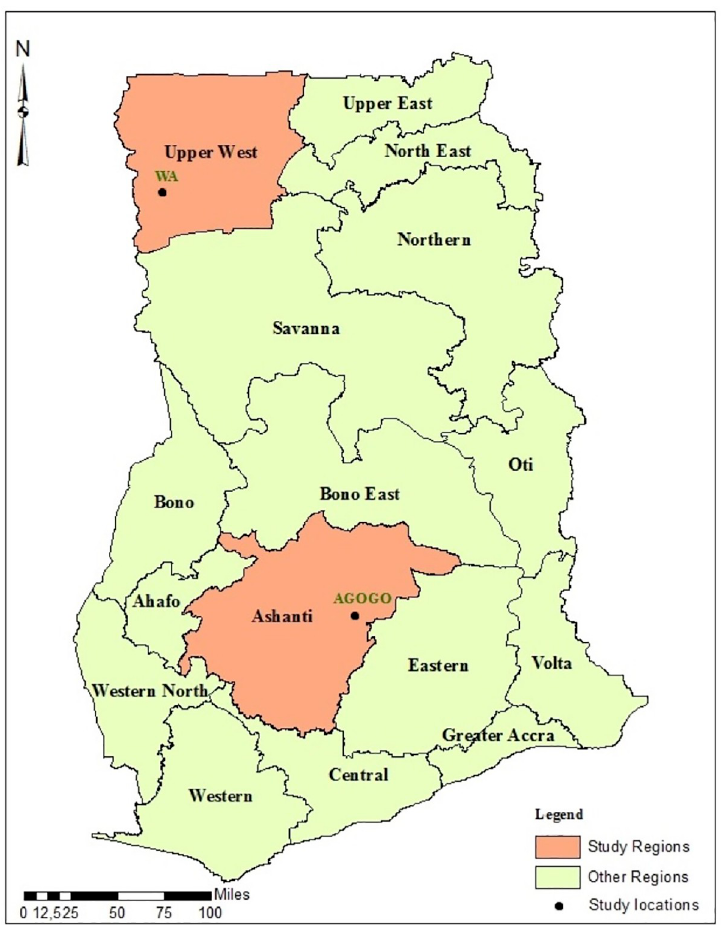
Fig 1. Study regions in Ghana (Created using ArcGIS 1 software version 10.5.1, ESRI Inc., Redlands, CA,